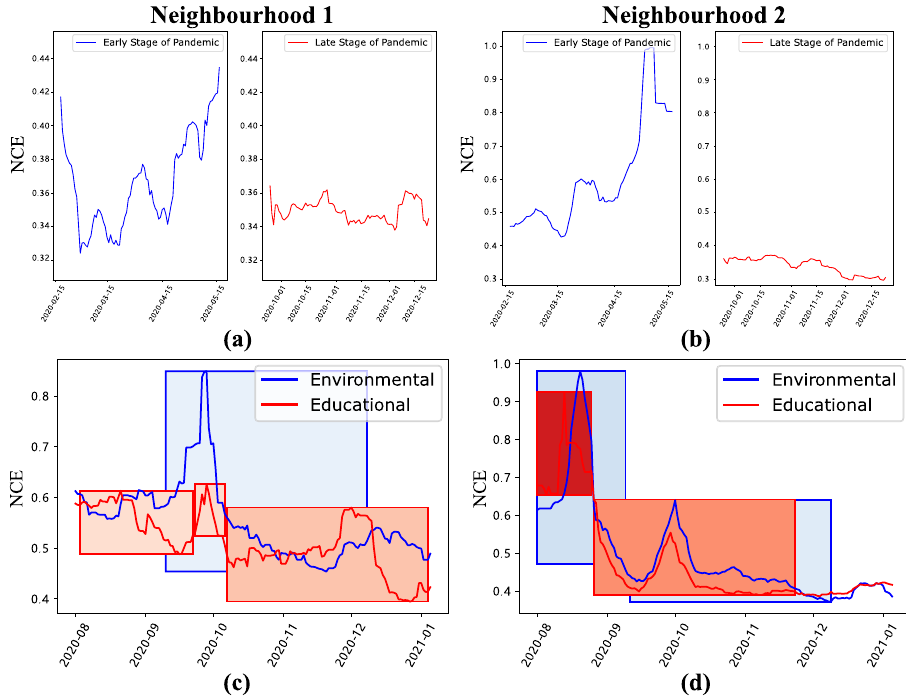
Fig. 8 Case Study: changes in organiser preference NCE under different supervision strengths. Colour shading in intervals indicates the magnitude of organisational speed. a , b Comparison of O-NCEs at different COVID-19 outbreak stages in the same neighbourhood. c , d Comparison of O-NCEs for environmental tasks (blue) and education tasks (red) in the same